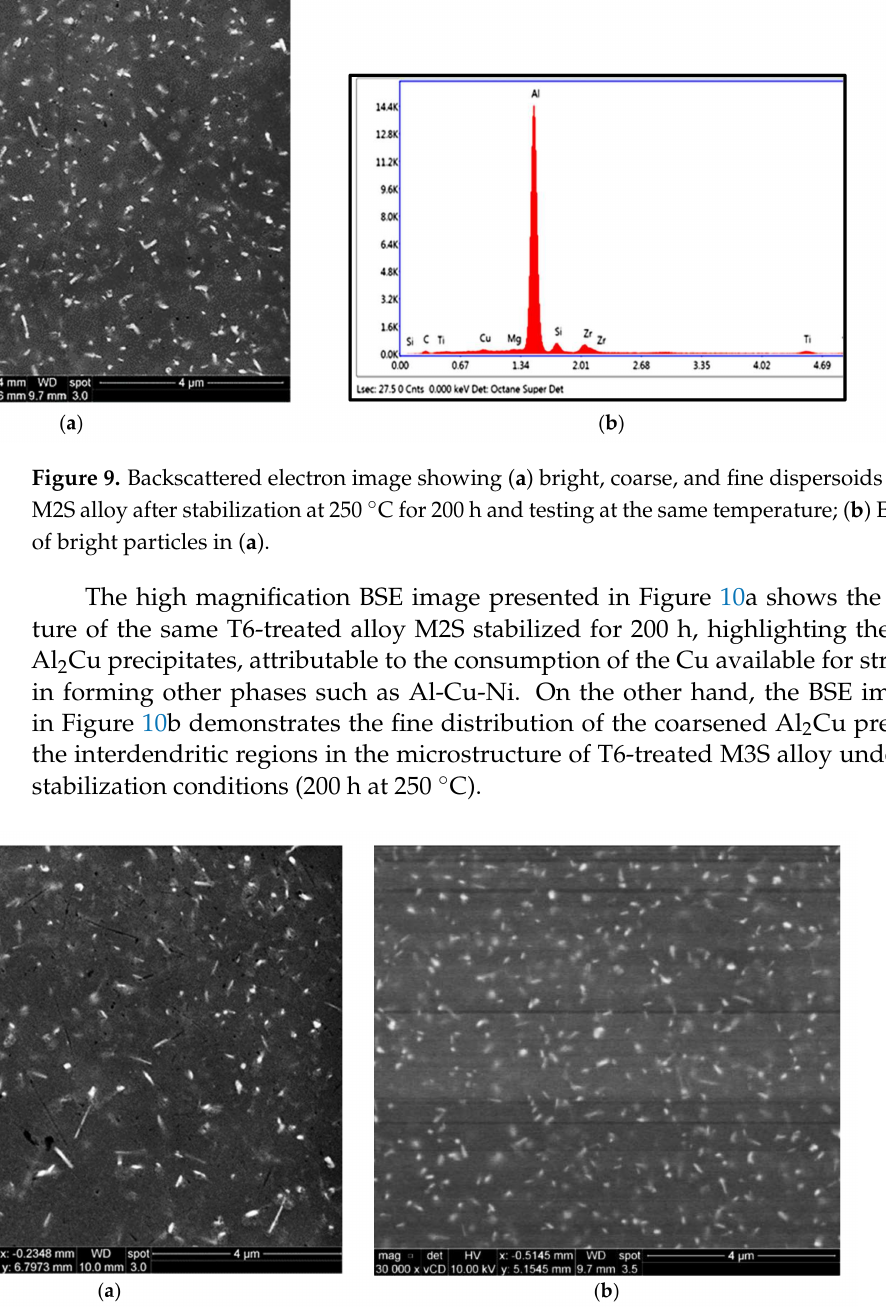
Figure 10. Backscattered electron images showing the density and distribution of the strengthening precipitates in T6-treated alloys after stabilization at 250 ◦ C for 200 h: ( a ) M2S, and ( b ) M3S alloy (tested at 250 ◦